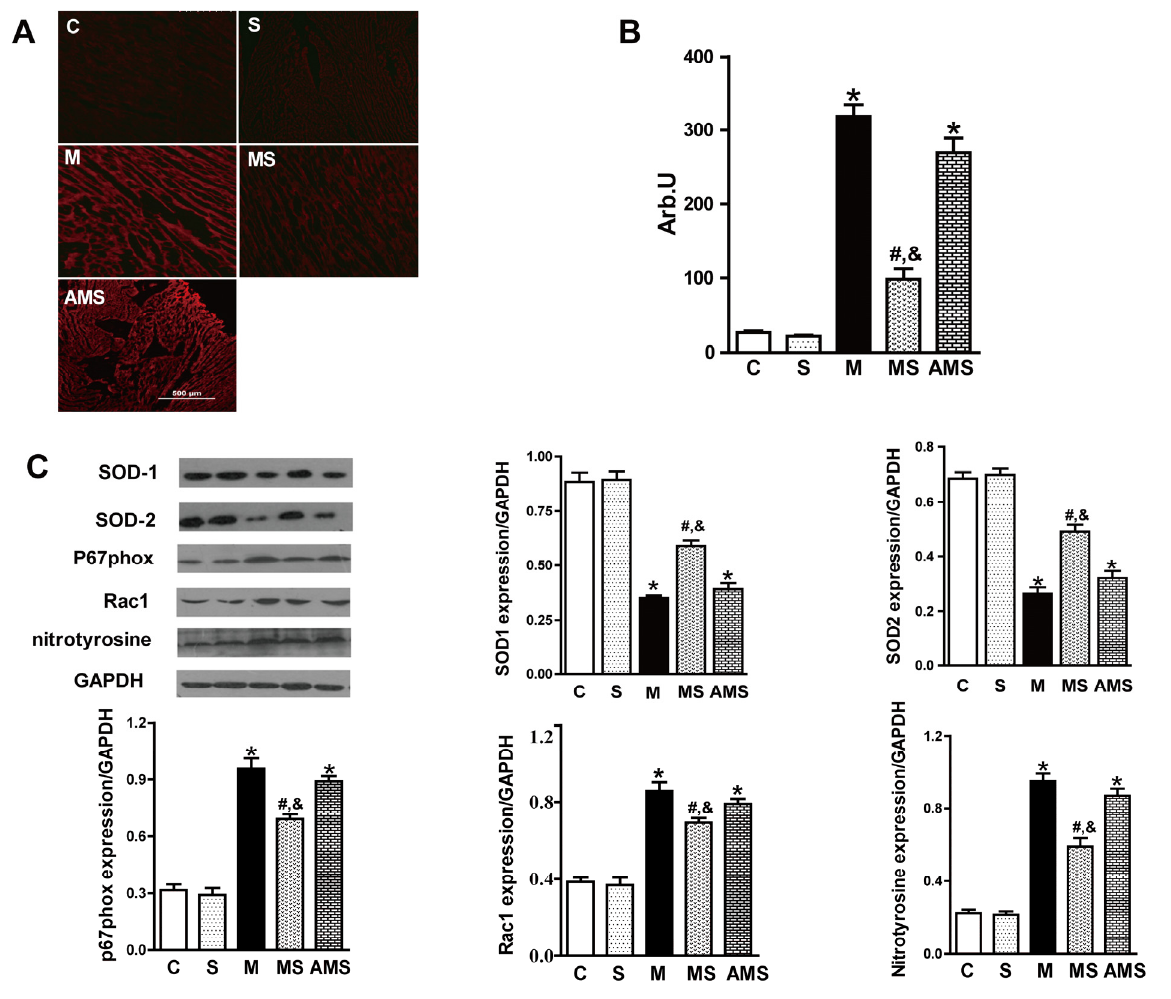
Figure 4. Effect of vagal stimulation on oxidative stress in rats with AMI. Rats in each group were sacrificed at the end of experiment and serum was